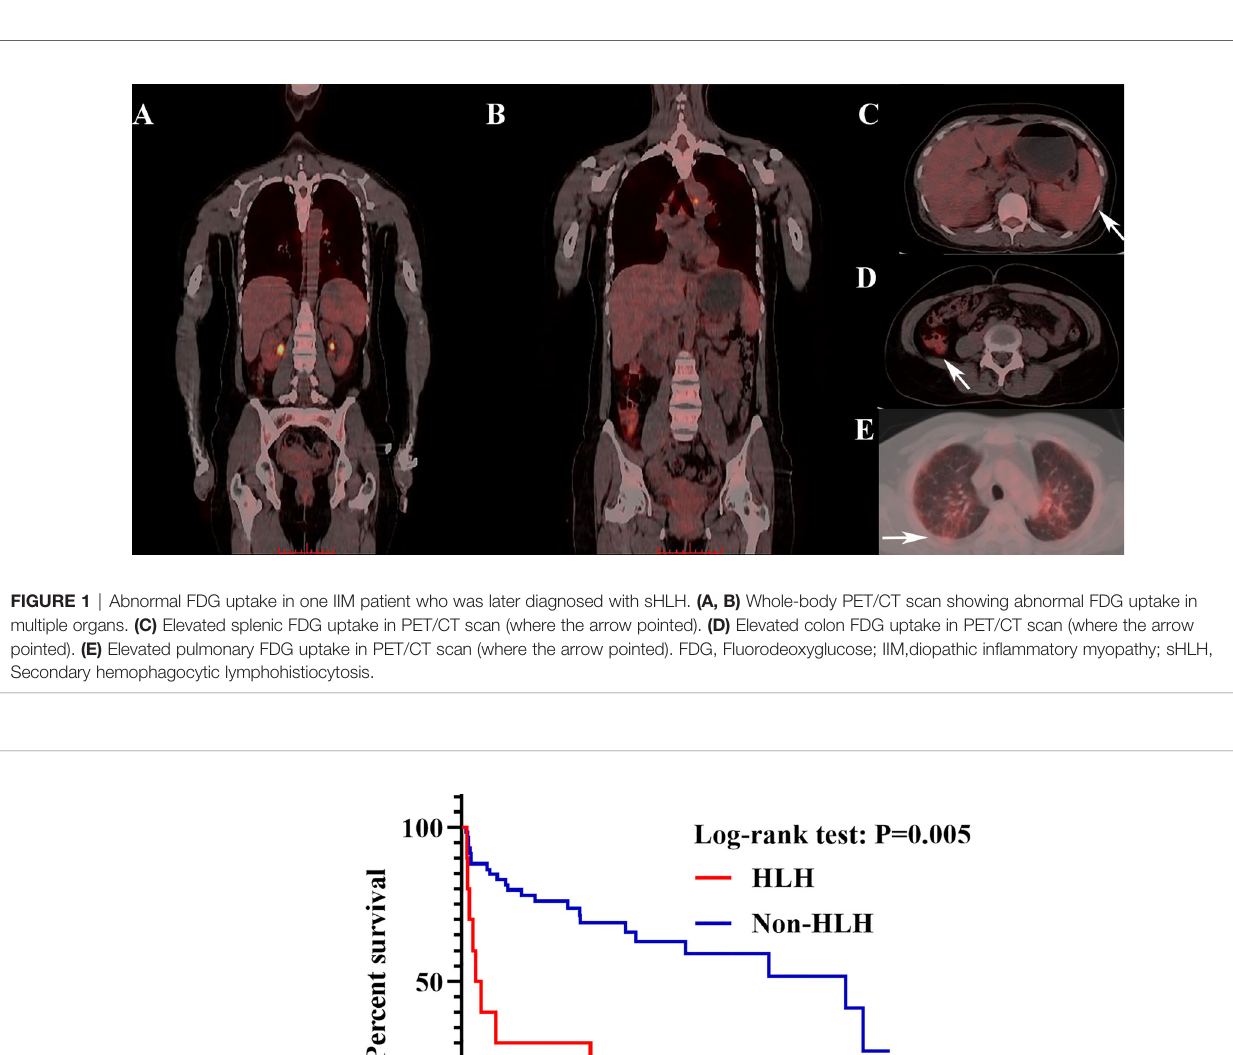
( Figure 4D ). To establish a more ef fi cient and balanced predictor fordevelopmentofsHLH,aseriesofmodelswereconstructedusing logisticregressionanalysisaboutIFN- g ,spleenSUVmean,andanti-